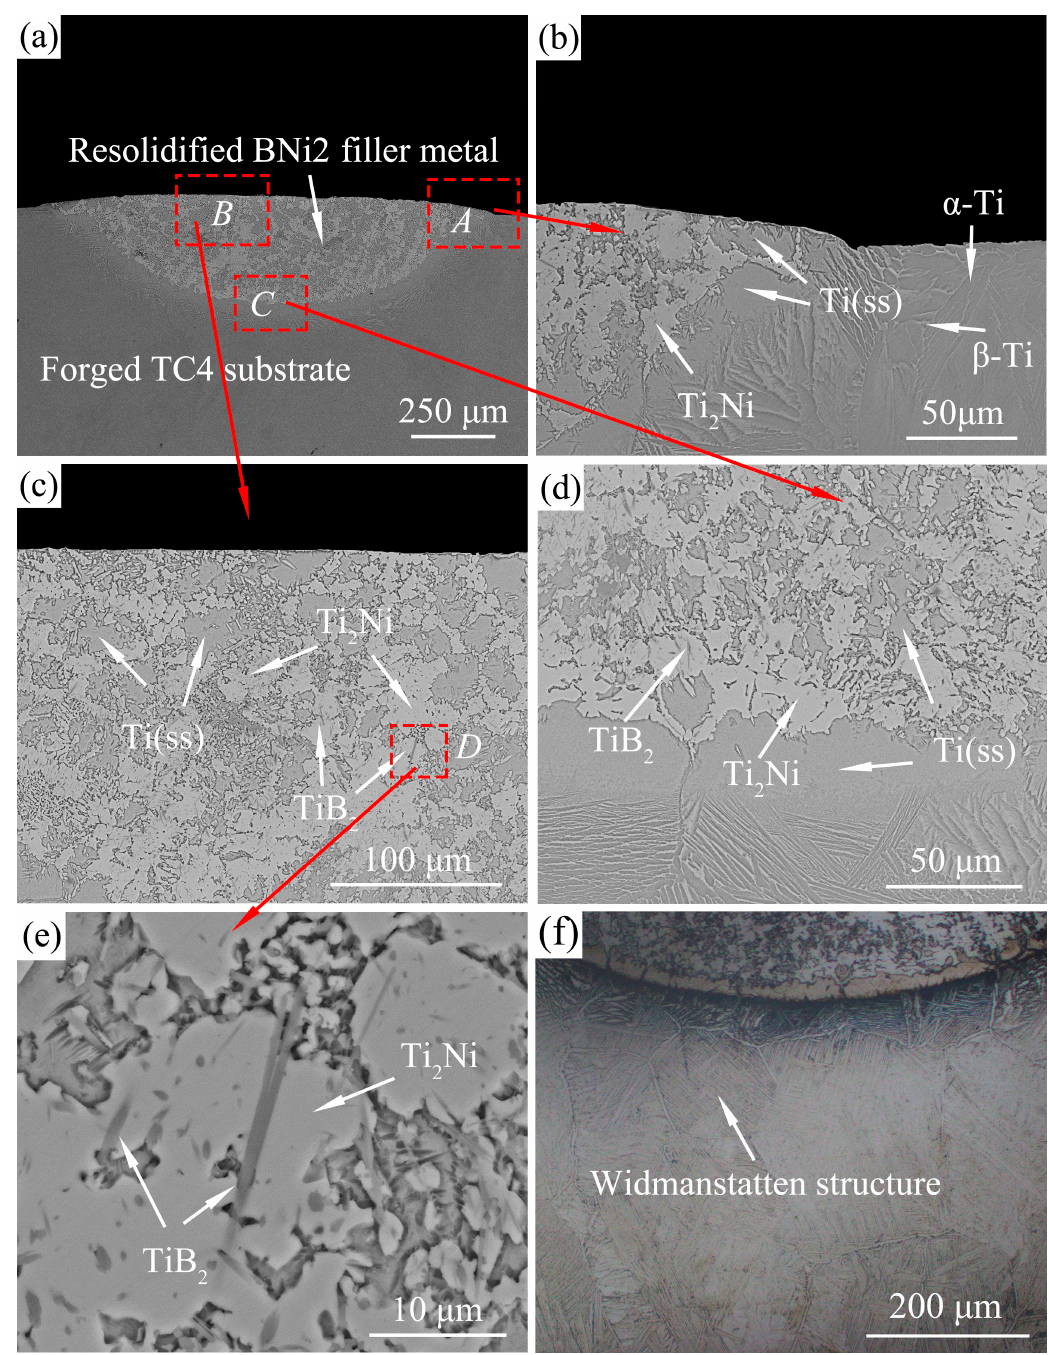
Figure 12. Typical resolidified BNi2 filler metal over the conventional forged TC4 with a peak temperature of 1080 °C and dwell time of 120 s: ( a ) the whole cross ‐ section; ( b ) the edge area of the cross ‐ section; ( c ) the central area of the cross ‐ section; ( d ) the bottom interface area of the cross ‐ section; ( e ) the magnified topography of area D in ( c ); and ( f ) the optical micrograph of the substrate after wetting.